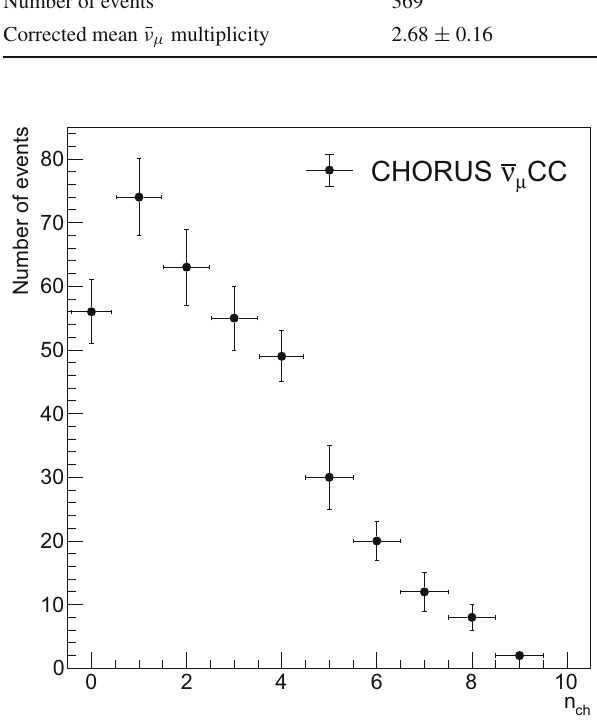
Fig. 1 Multiplicity distribution of ¯ ν μ -nucleus in nuclear emulsion